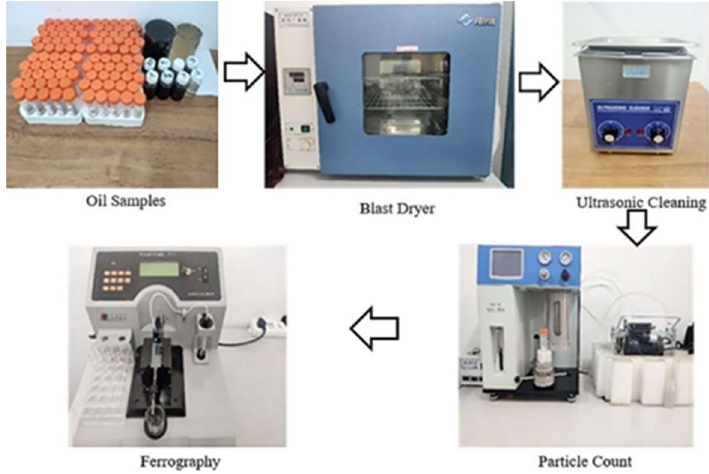
Figure 6. Flow chart of oil treatment.